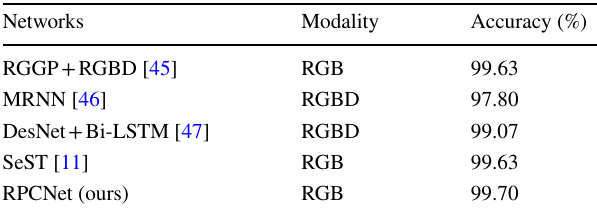
Table 5 Comparison results of our models with other state-of-the-art methods on the test set of SKIG [13] dataset Networks